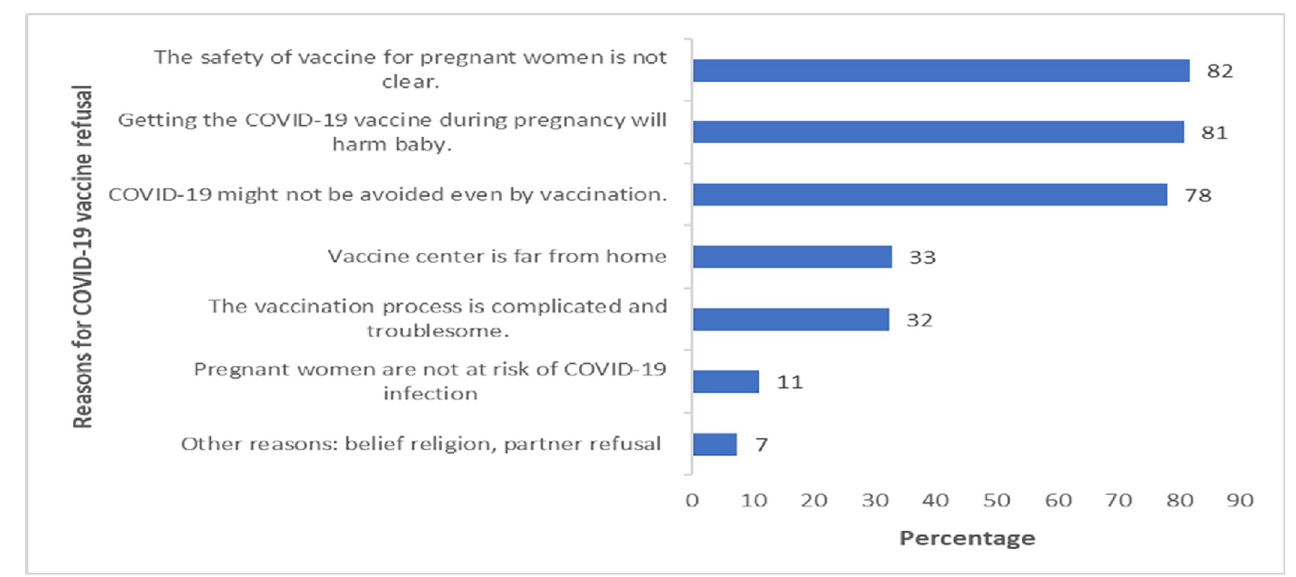
Fig 2. Reasons for refusal of COVID-19 vaccine by pregnant women. https://doi.org/10.1371/journal.pone.0278694.g002 perception (AOR = 2.152; 95% CI 1.109–4.178; p = 0.023) were found to be statistically signifi- cant for acceptance of COVID-19 vaccine among pregnant women. Table 5 shows that the Pearson correlation test revealed a statistically significant negative correlation between perception of COVID-19 vaccine acceptance (r = − 0:80; p 0.025) and a non-significant correlation between awareness of COVID-19 vaccine and acceptance of vac- cine (r = -0.02 p = 0.605).